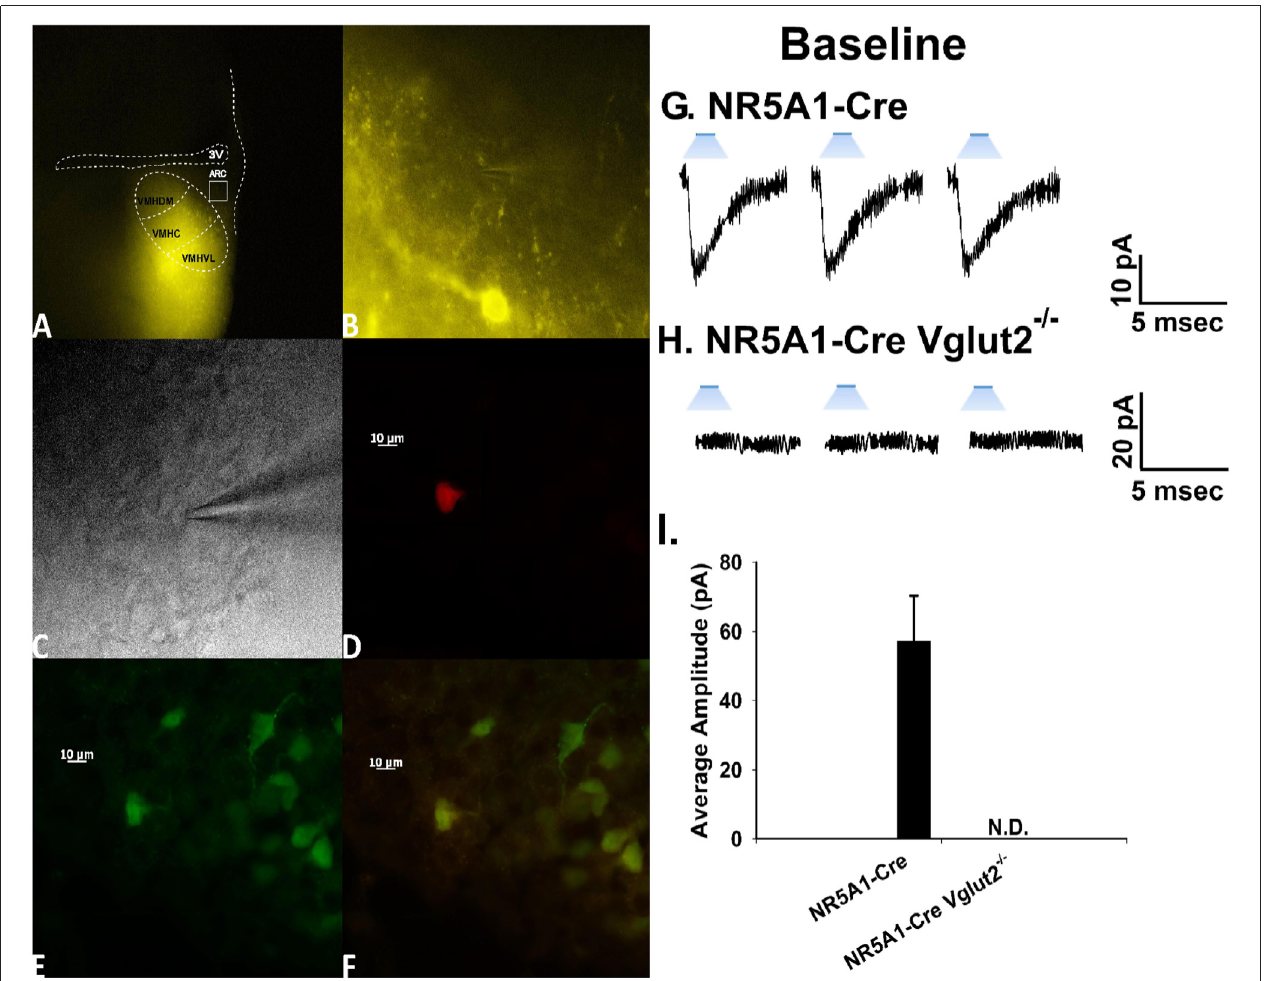
FIGURE 6 | Photostimulation elicits glutamatergic EPSCs at VMN steroidogenic factor (SF-1)/ARC POMC synapses. (A) ChR2 labeling in the VMN of a male NR5A1-Cre mouse visualized at × 4 with enhanced yellow fluorescent protein (eYFP) 2 weeks after injection with a ChR2-containing virus. Of note is the gradient extending from the dorsomedial VMN (VMHDM) to the ventrolateral VMN (VMHVL) that is characteristic of the distribution of VMN SF-1 neurons. (B) Magnified view of the outlined approximate recorded area in the ARC from (A) showing labeling of ChR2-containing fibers in the ARC visualized with eYFP. (C) An infrared, differential interference contrast image taken of an ARC neuron in close proximity to the eYFP-labeled fibers seen in (B) . (D) Biocytin labeling of the cell in (A) visualized with streptavidin/Alexa Fluor 546. (E) An antibody directed against cocaine- and amphetamine-regulated transcript (CART), a phenotypic marker of POMC neurons, immunolabels the cell in (C) as visualized with Alexa Fluor 488. (F) A composite overlay of the biocytin/CART labeling seen in the cell in (A) . Unless otherwise indicated, all photomicrographs were taken at × 40. A 25-ms stimulus of blue light subsequently delivered to the cell in (C–F) elicited robust light-evoked EPSCs (leEPSCs; G) that were indiscernible in recordings from NR5A1-cre Vglut2 − / − animals (H) . This is further illustrated in the composite bar graph in (I) Bars represent means and lines 1 SEM of the EPSC amplitude measured in slices from NR5A1-Cre ( n = 22) and NR5A1-Cre Vglut2 − / − ( n = 3)